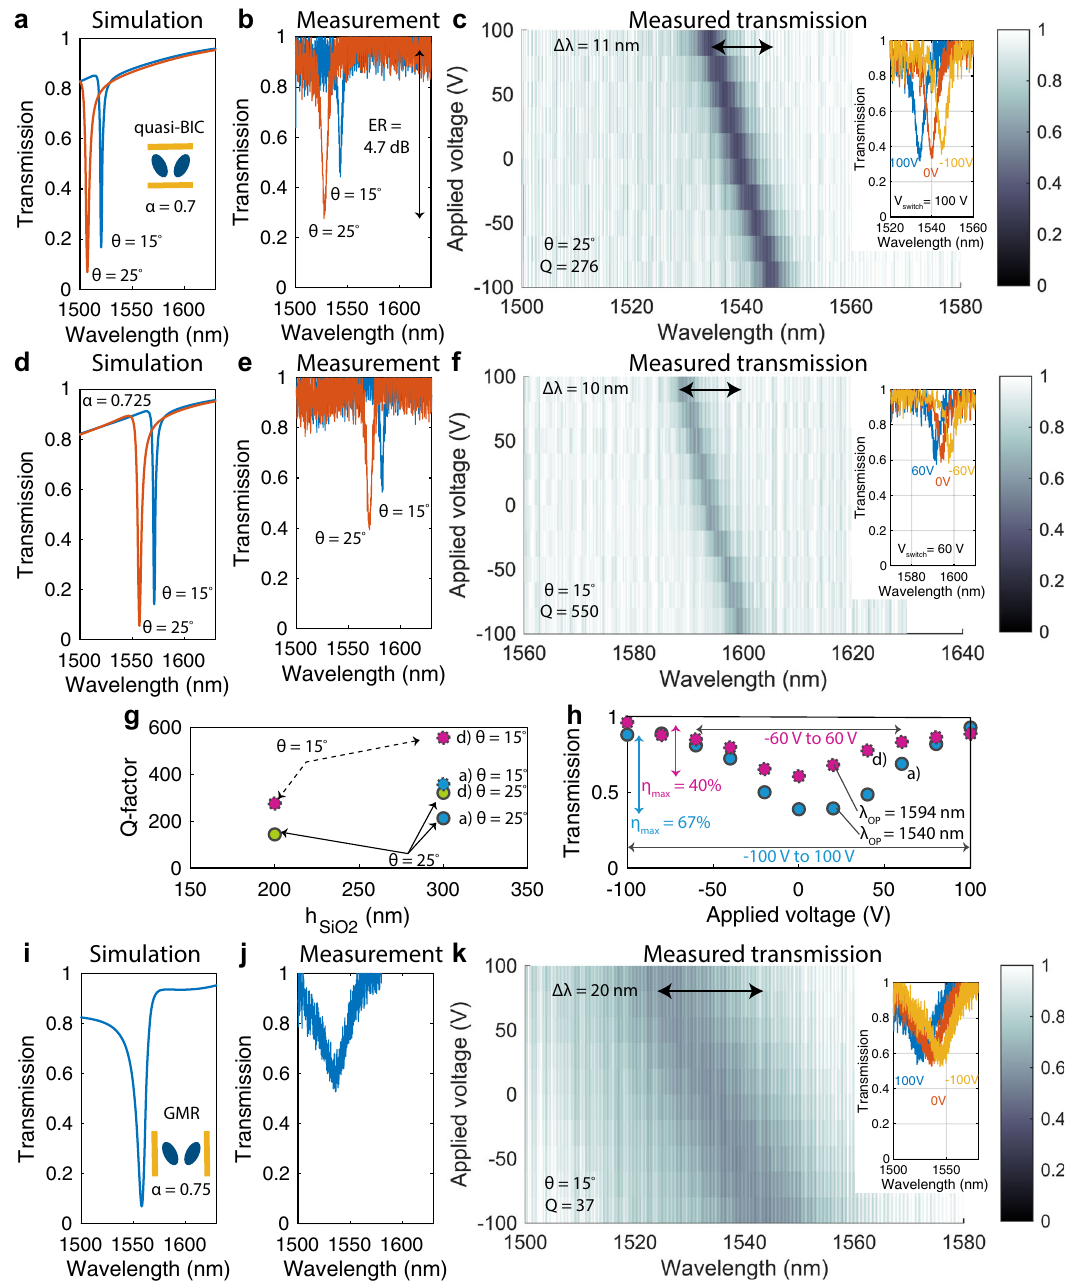
Fig. 3 DC tuning properties of Mie-based modulators. a , b and d , e Experimental transmission results are compared to simulated transmission curves for various geometries of electro-optic modulators based on quasi-BIC structures. We fi nd, as expected, by experiment and simulation, that the geometrical scaling factor α shifts the resonances within the telecom band. In addition, the asymmetry angle θ in fl uences the linewidth of the resonances. c , f are DC tuning maps of the electro-optic modulators for ( α , θ ) = (0.7, 25°) and ( α , θ ) = (0.725, 15°), respectively. Insets show three distinct curves at 0 V, and V = ± 100 V and ± 60 V, respectively. g Experimentally extracted quality factors for two distinct heights of the silicon dioxide pedestal are compared switch and we fi nd that an increase in height from 200 to 300 nm leads to an increase in the quality factor. Dashed circles represent quasi-BIC structures with θ = 15° and full contour circles represent θ = 25°. The circles for h = 300 nm denote the measurements as labeled to the right of the circles. The circles SiO 2 for h SiO 2 = 200 nm represent measurements of equivalent structures with h SiO 2 = 200 nm. h Detailed voltage-dependent transmission curves are reported for two exemplary operating wavelengths for the case of the two device geometries discussed in a , d . Full switching of transmission is achieved for both geometries. i , j In contrast, GMRs in the same structure have much broader linewidths, demonstrated by experiment and simulation. k Their resonance ¼ 20nm. Q factors and asymmetry angle θ are indicated for all colormaps. ER extinction wavelength can be tuned over Δ λ res